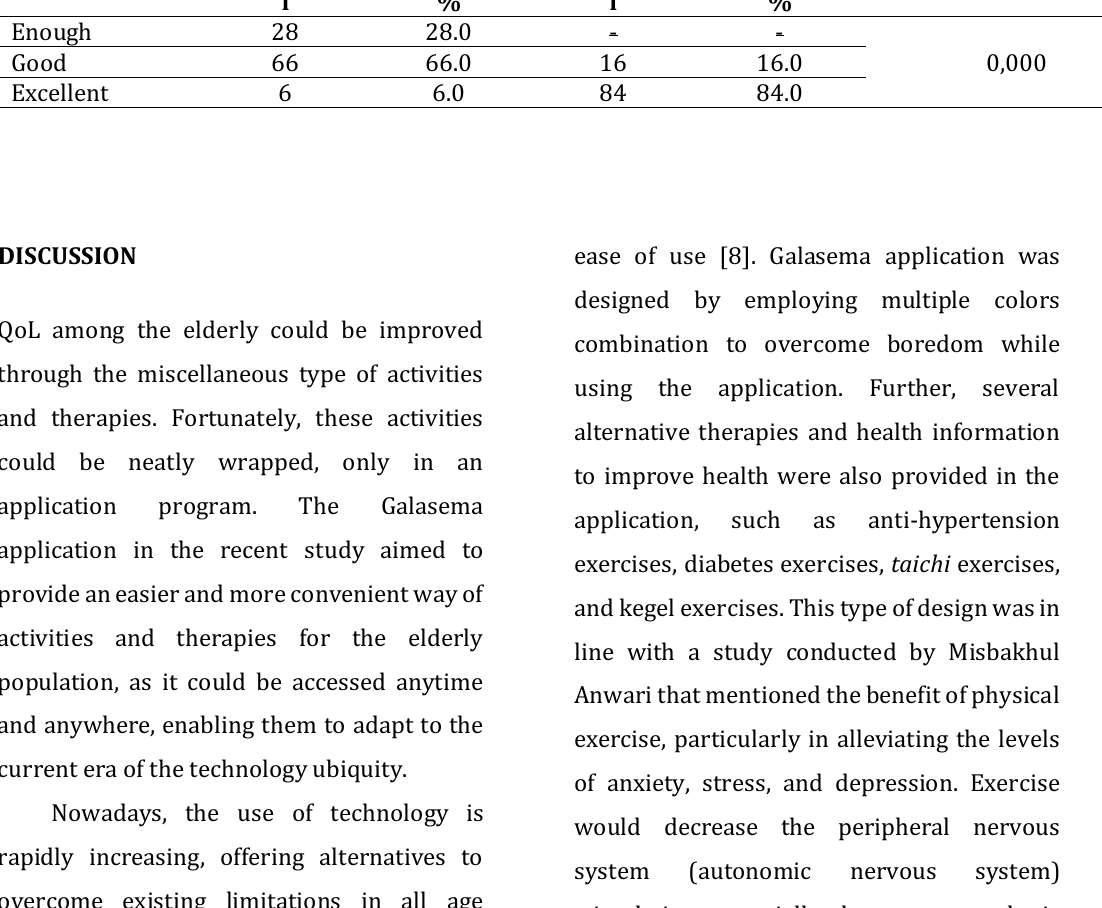
Table 2 Distribution of Pre-test and Post-test Quality of Life Levels Indicator Enough